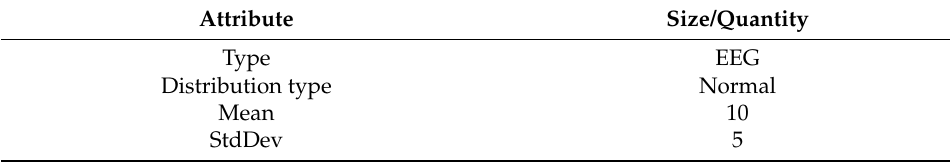
Table 5. Sensor 1 Characteristics.